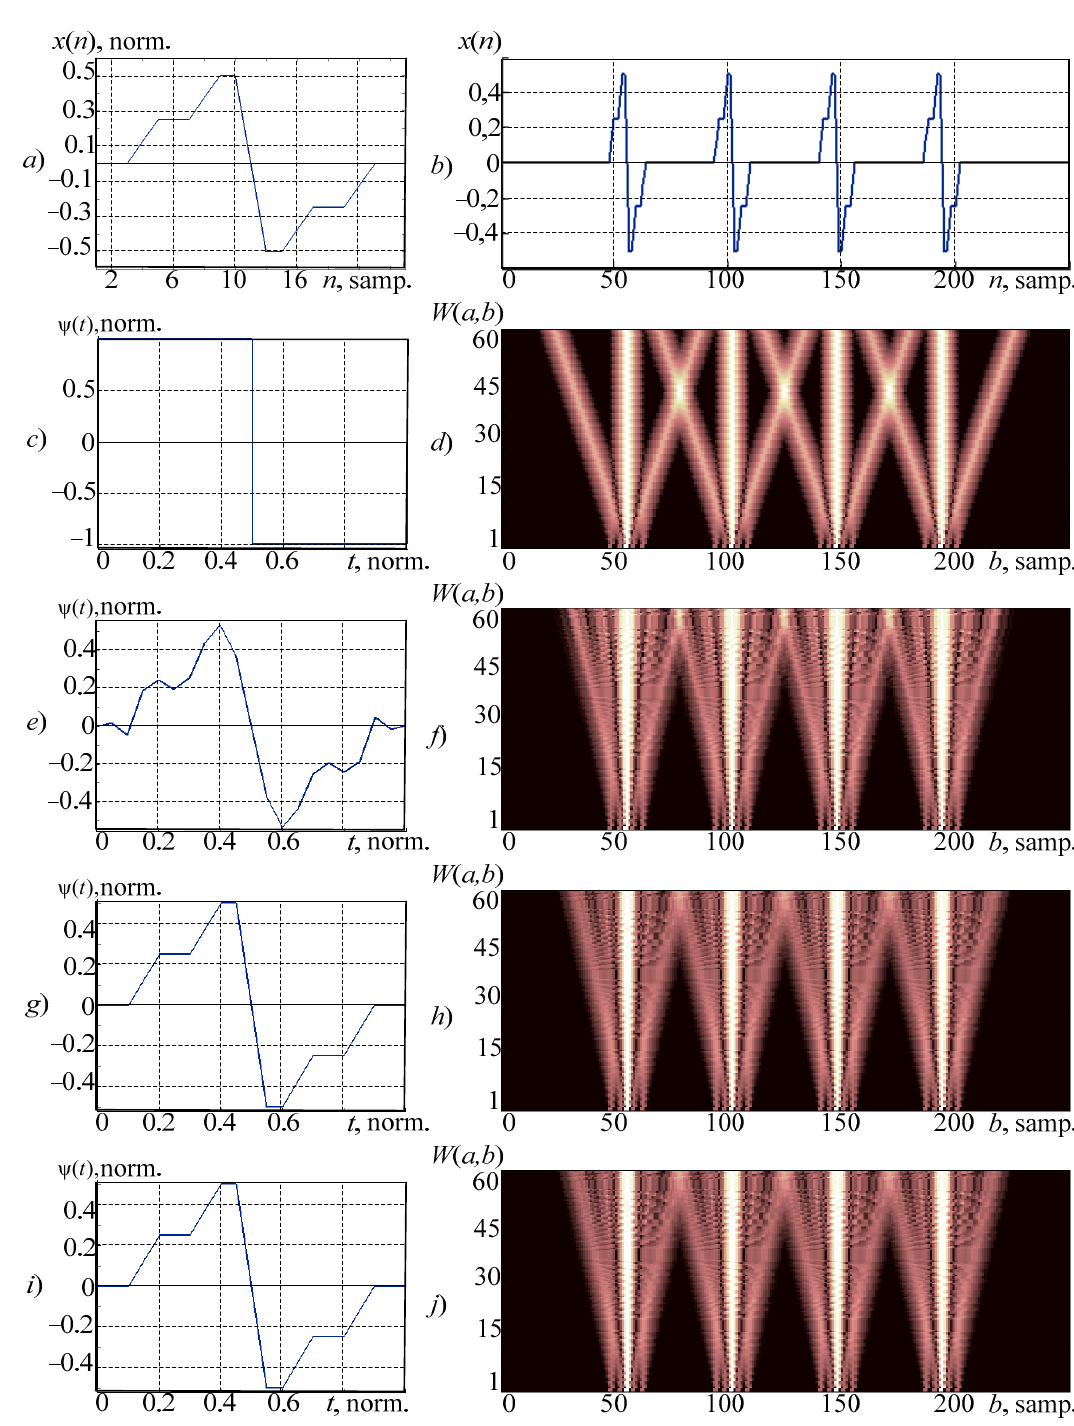
Figure 4. Results of research on synthesized wavelets: ( a ) the sample; ( b ) the analyzed signal; ( c ) the Haar wavelet; and the wavelet-spectrogram ( d ) that was obtained with its application; ( e , g , i ) the wavelets, obtained on the basis of polynomial, neural network, and spline models, respectively (before normalization); ( f , h , j ) wavelet-spectrograms obtained using synthesized wavelets ( e , g , i ), respectively. Table 2. The results of mathematical wavelet models obtained for analysis of broken signal’s study. Mathematical Model Number of Models’ Parameters Maximum Deviation, Norm.